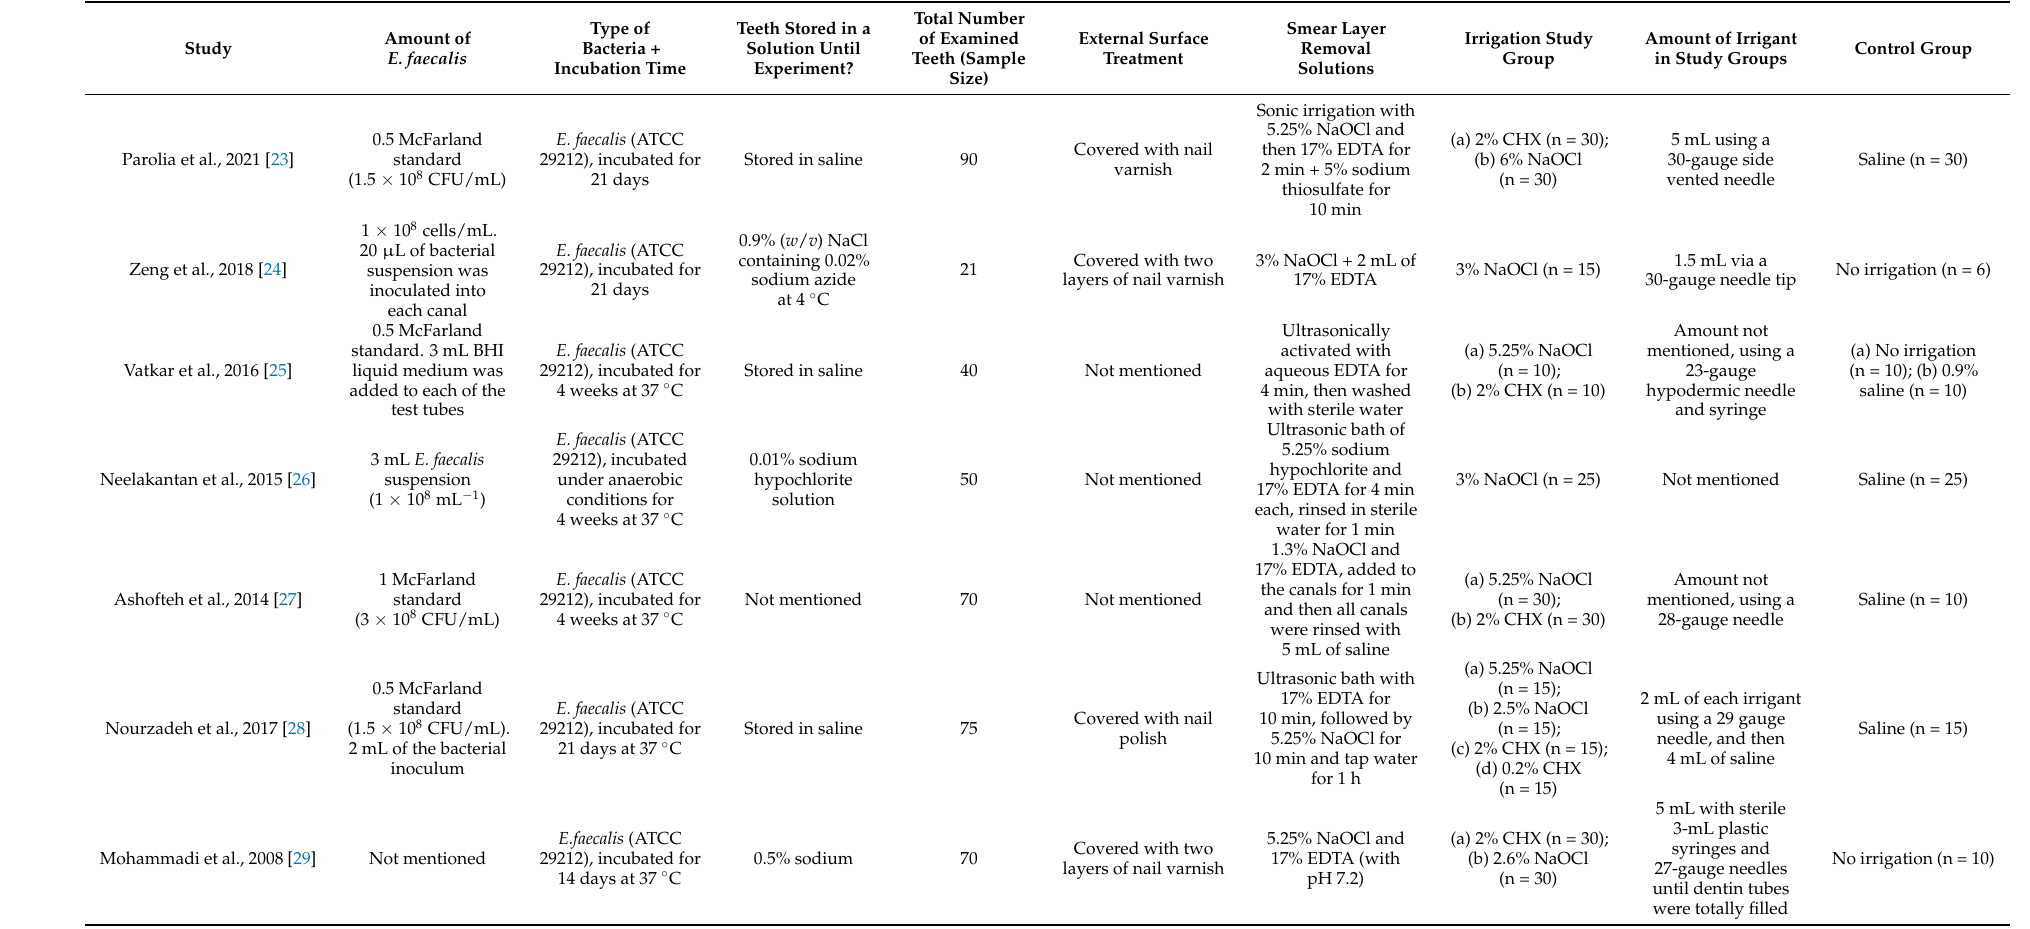
Table 1. Characteristics of included